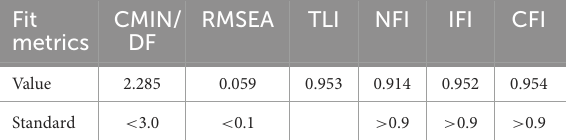
TABLE 1 SEM model fit analysis.